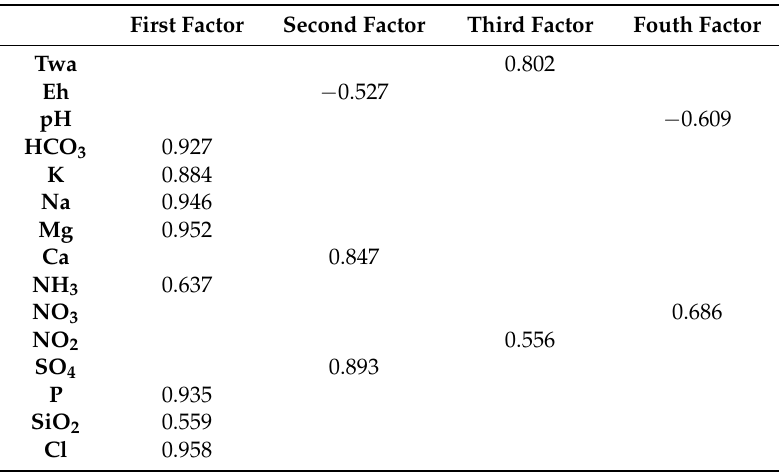
Table 2. Rotated Component